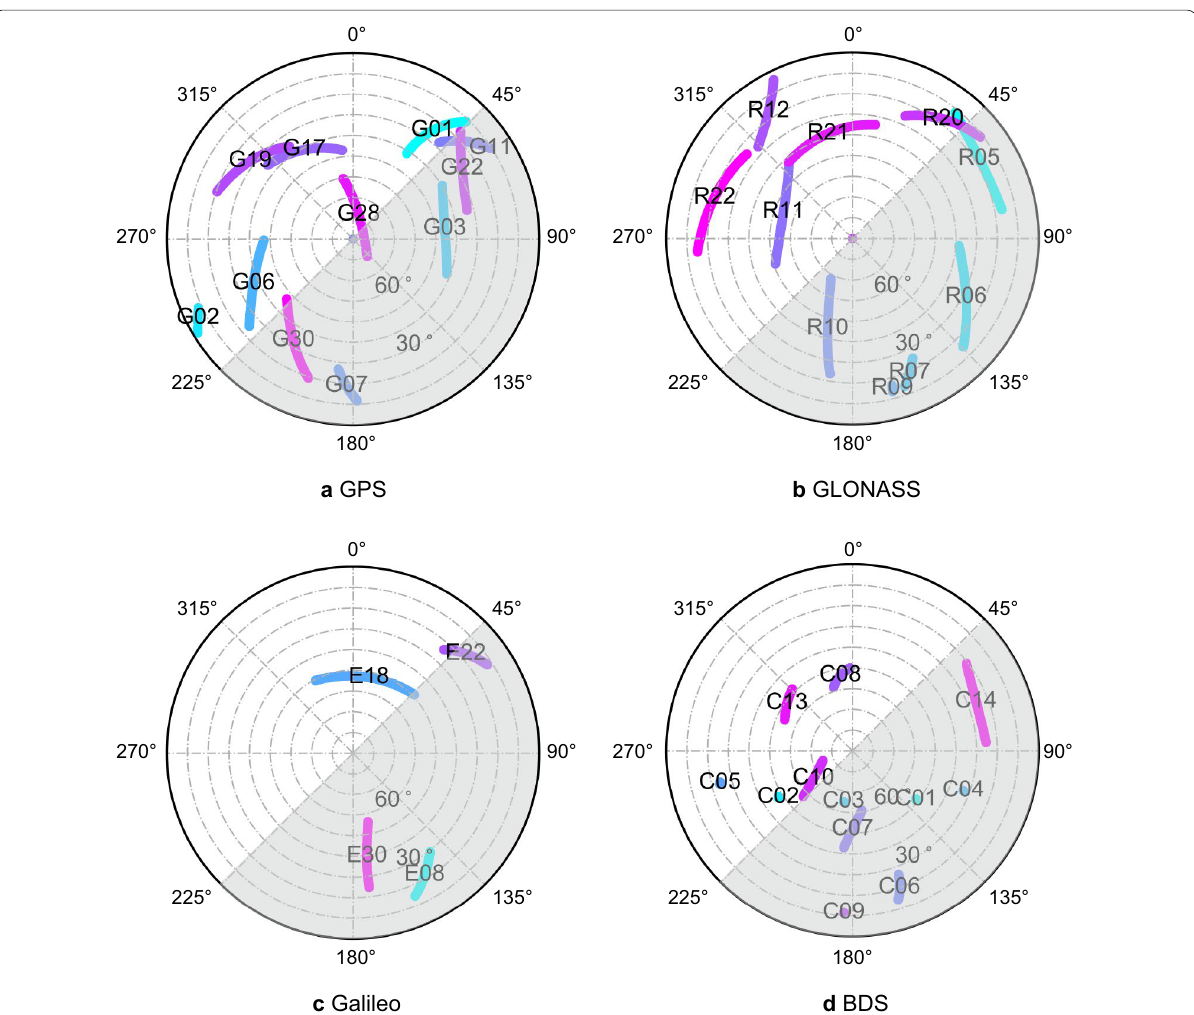
Fig. 4 Satellite distribution in sky view for different GNSS systems, i.e., GPS in ( a) , GLONASS in ( b ), Galileo in ( c ), and BDS in ( d ). Its time duration is from 15:08 to 16:28 HKT on 19 June 2017. The gray mask indicates that satellites in the mask are not visible for the moving